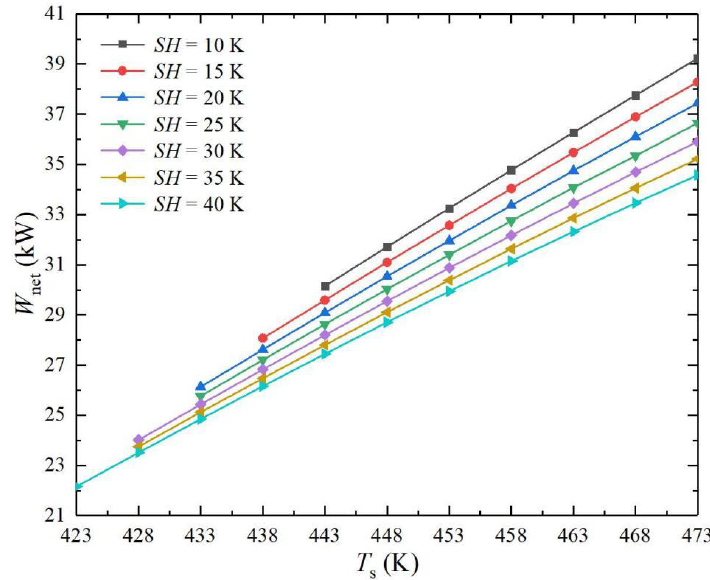
Figure 19. Influence of the power output on the superheat degree.